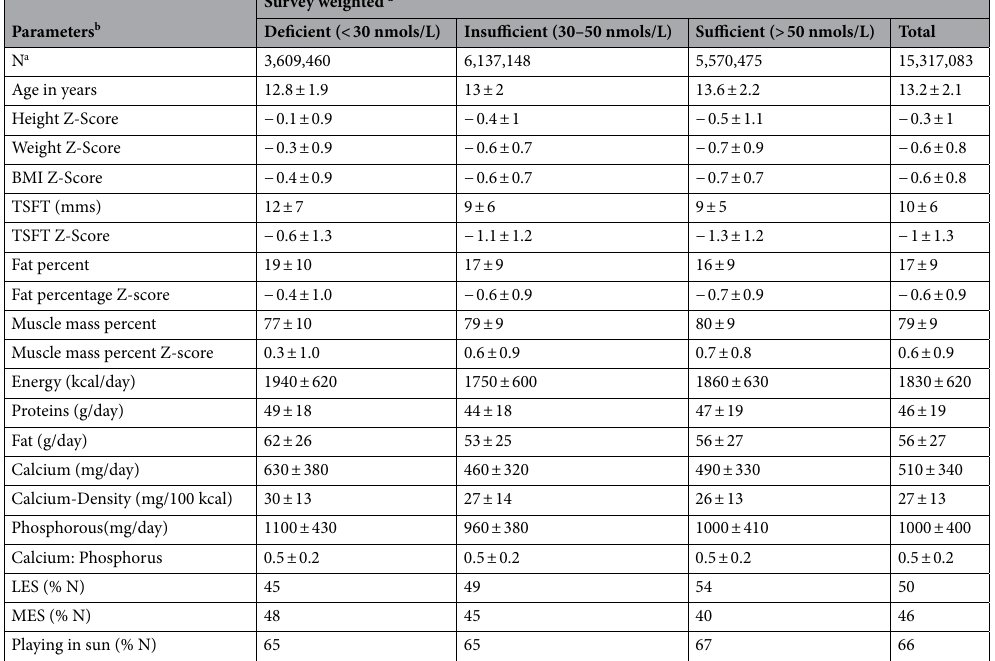
Table 3. Comparison of socio-economic status, anthropometry, body composition and lifestyle factors of children and adolescents based on vitamin D concentrations (n = 669, all values are survey-weighted a ). TSFT Triceps skinfold thickness, LES lower socioeconomic class, MES middle socioeconomic class. a Survey weighted descriptive as per Indian population Census 2011 21 . b All the groups were significantly different from each other, p <